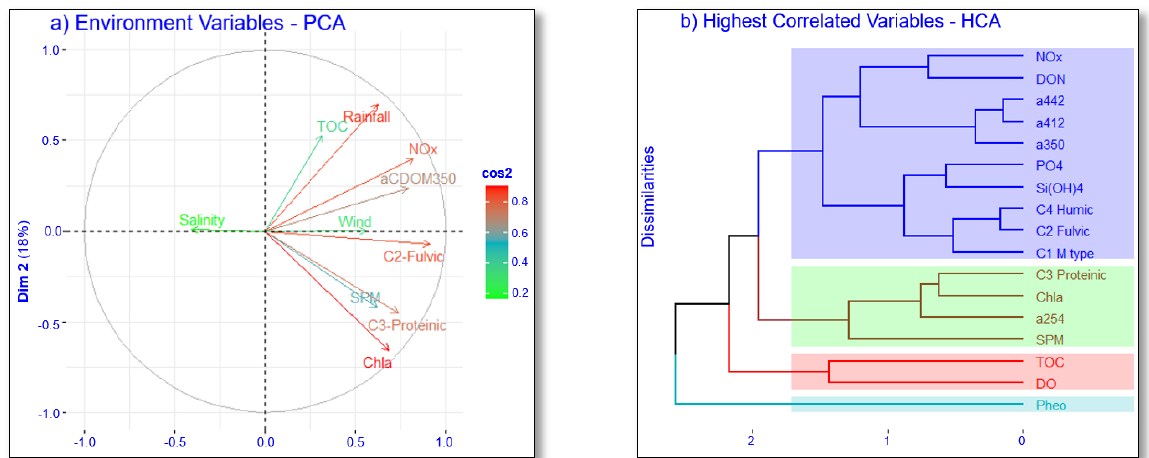
Figure 10. ( a ) Principal component analysis (PCA) with Pearson correlation and quality representation on the correlation circle, cos2 square cosine, squared coordinates and ( b ) Hierarchical (K-means) Cluster Analysis, HCA (k = 4) for “complete (furthest distance)” agglomeration method.